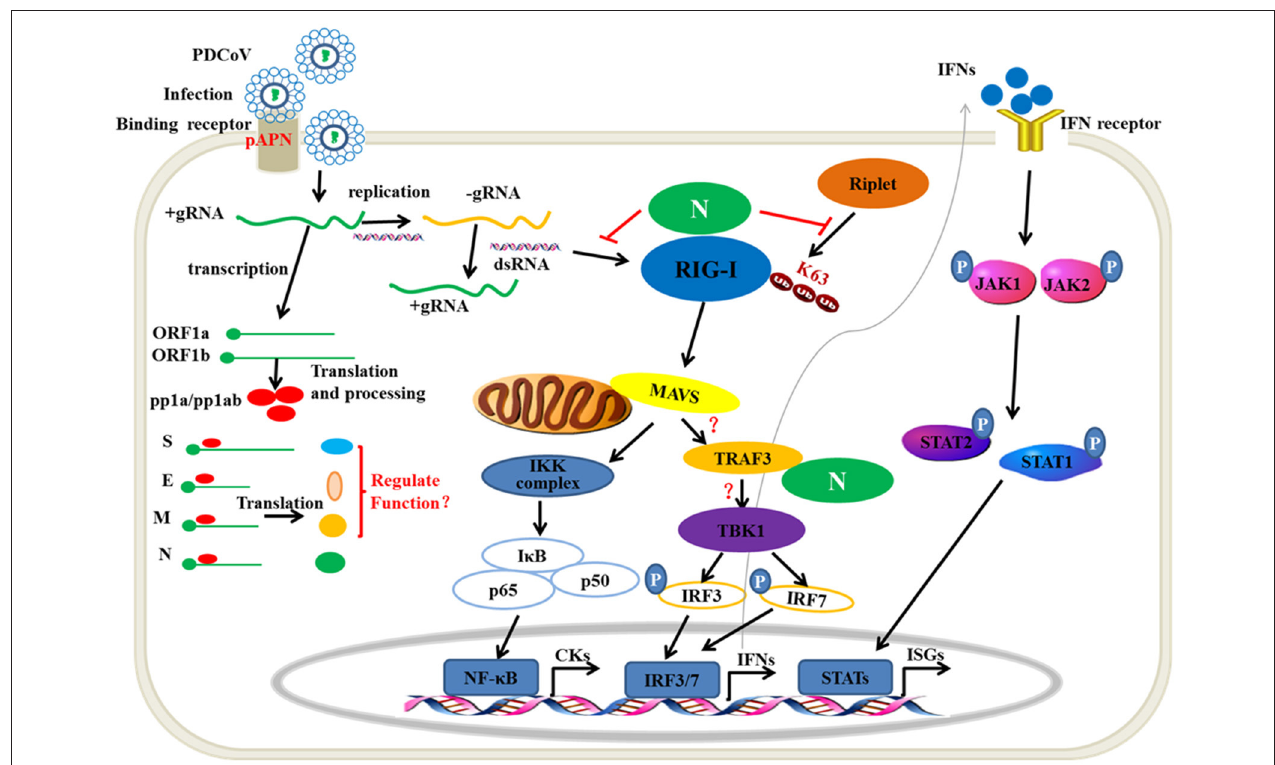
FIGURE 8 | The mechanism of PDCoV N protein interfered with the type I IFN response. PDCoV infect the host cells by attaching to the celluar receptor porcine APN. In the cytoplasm, PDCoV release the viral genomic RNA and then complete the transcription and replication process. The ssRNA as well as dsRNA as replicative intermediate are sensed by porcine innate nucleic acids sensors in the cytoplasm to induce the IFNs production, such as porcine RIG-I. The E3 ubiquitin ligase Riplet is shown to active RIG-I by K63-linked polyubiqutination. Activation of JAK-STAT pathway by IFNs binding its receptor induces the production of ISGs, such as OAS1 , ISG15 . In the present, PDCoV N protein can block the porcine RIG-I dsRNA-binding and interferes with porcine Riplet-mediated porcine RIG-I K63-linked polyubiquitination to restrain the type I IFN response. PDCoV N protein also interacts with porcine TRAF3. However, the mechanism of the association is unclear. The other viral structure proteins are unclear in regulating type I IFN